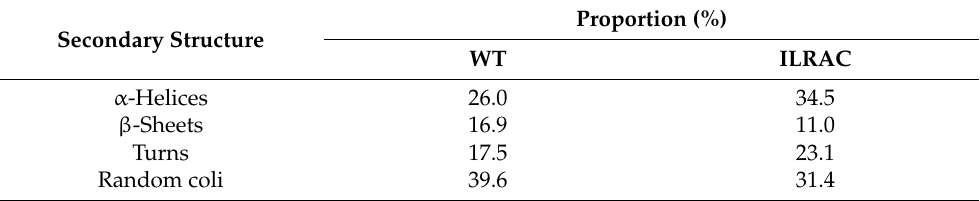
Table 2. Secondary structures analysis of wild-type and mutant ILRAC by circular